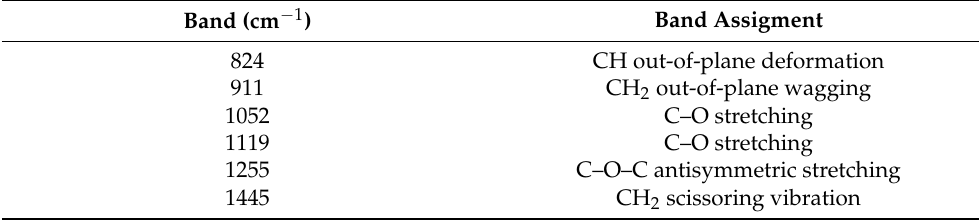
Table 3. Vibrational frequencies used for the sucrose quantification with PLS analysis